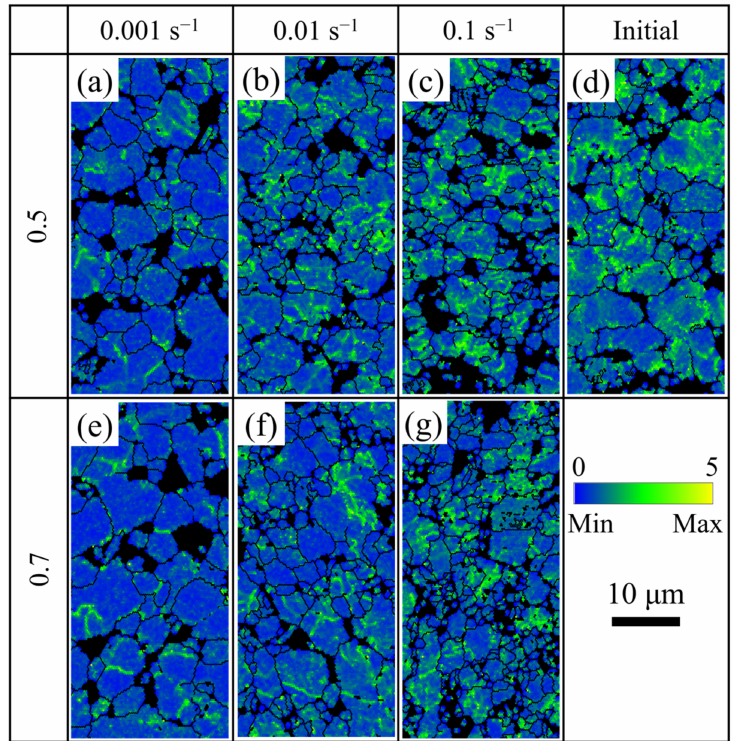
Figure 9. The distributions of KAM at different strains and strain rates when deformed at 950 ◦ C: ( a – c ) strain 0.5; ( d ) initial; ( e – g ) strain 0.7; ( a , e ) strain rate 0.001 s − 1 ; ( b , f ) strain rate 0.01 s − 1 ; ( c , g ) strain rate 0.1 s − 1